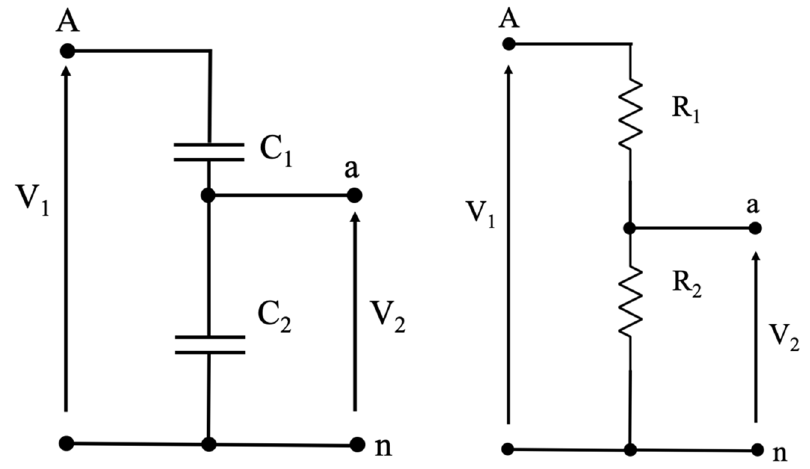
Figure 2. Working principle of a capacitive ( left ) and a resistive ( right ) low-power voltage transformer (LPVT).